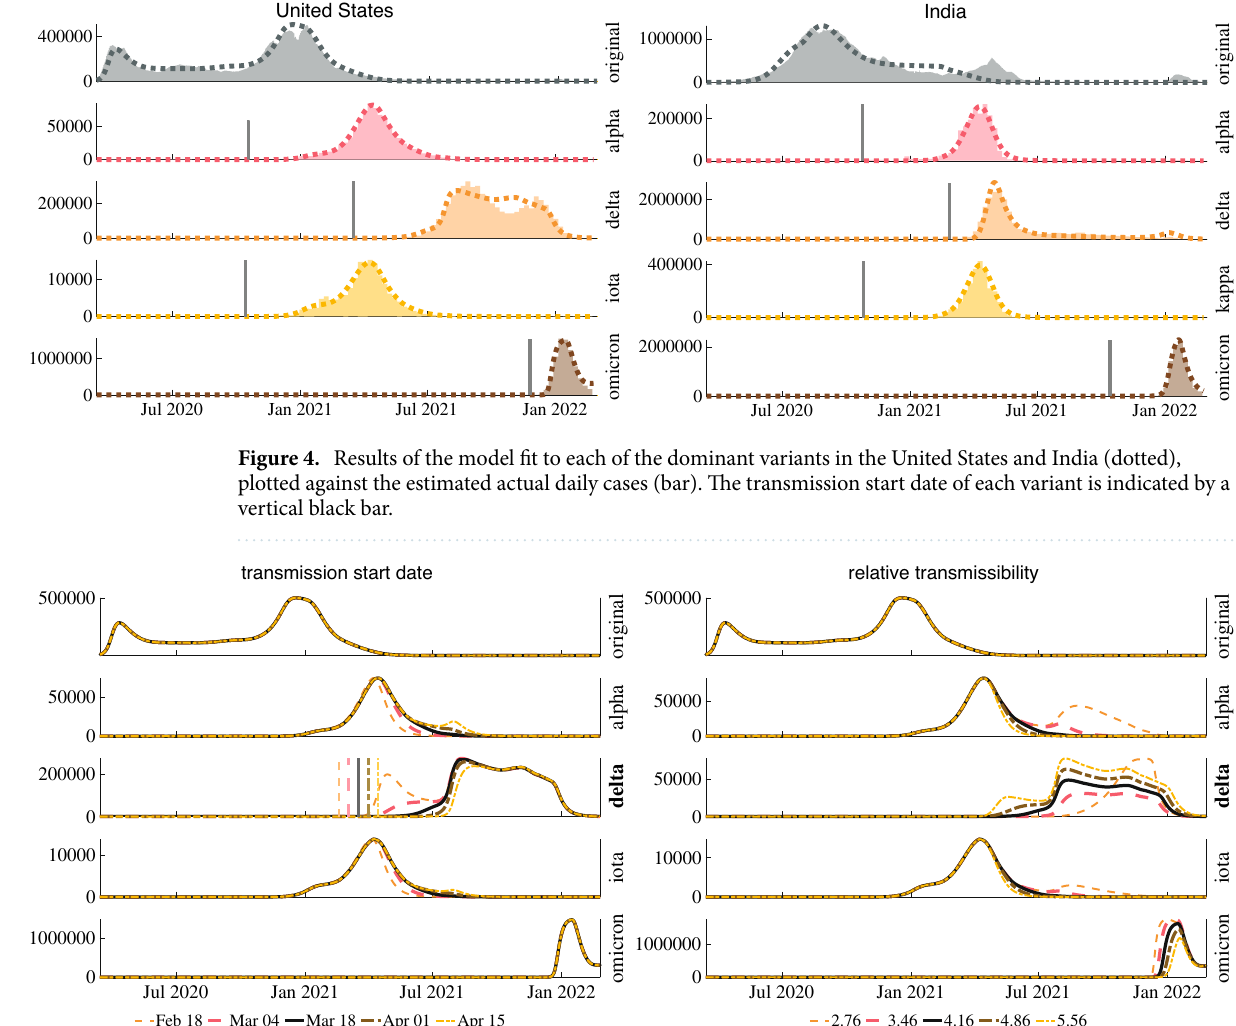
Figure 5. Effect of transmission start date and relative transmissibility of the Delta variant on COVID-19 cases among all dominant variants in the United